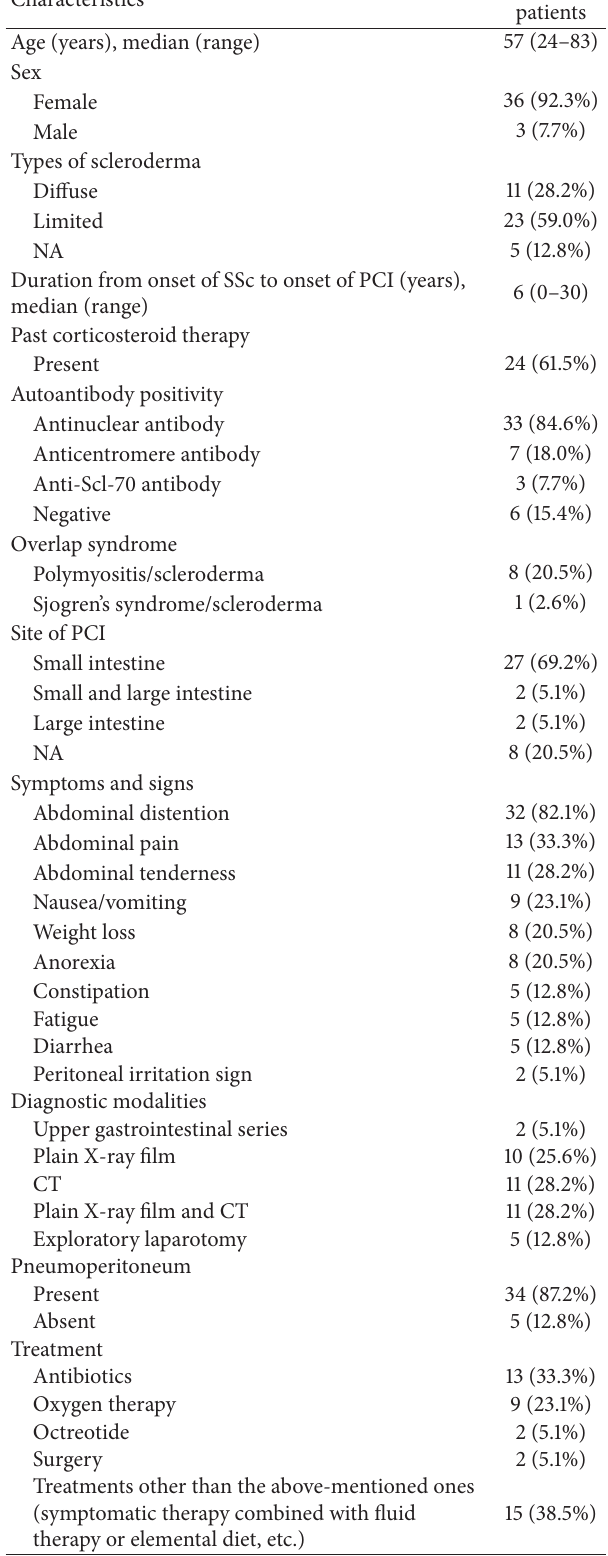
Table 2: Demographic data for 39 Japanese cases of SSc with